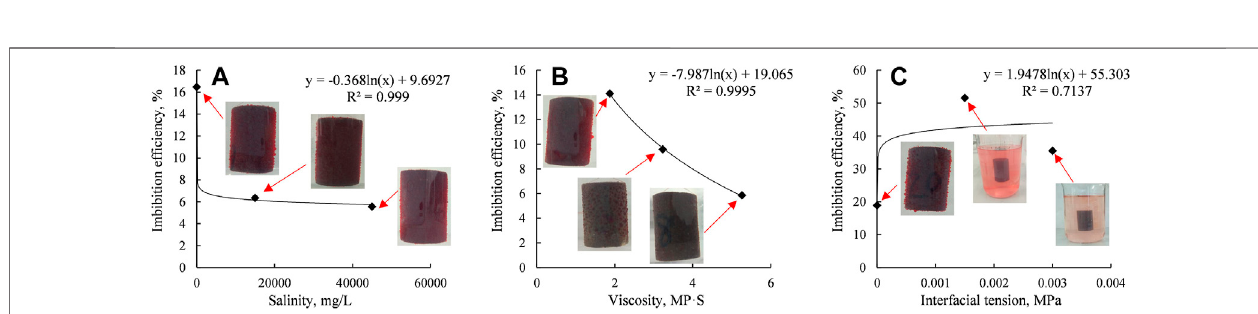
Frontiers in Physics |